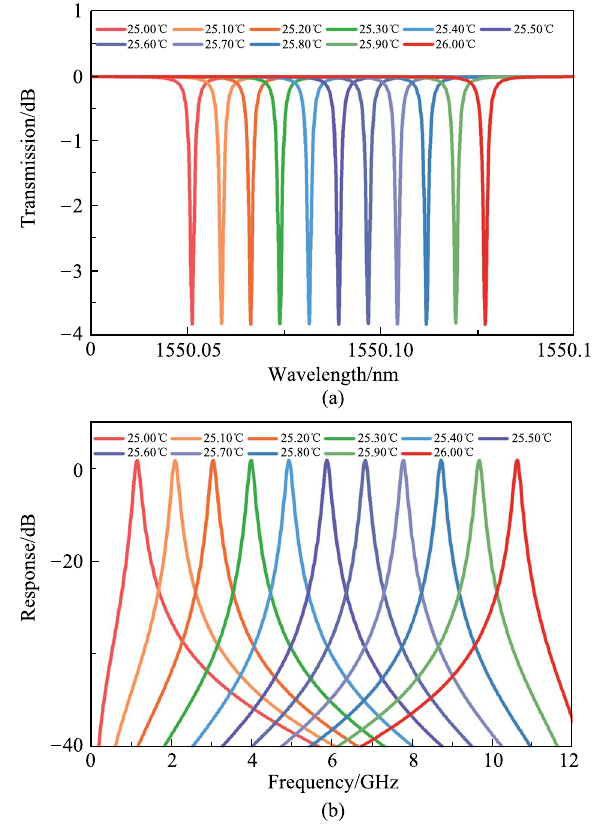
Fig. 3 Simulated results of a the transmission spectra of the MRR and b the responses of the MPF with changed